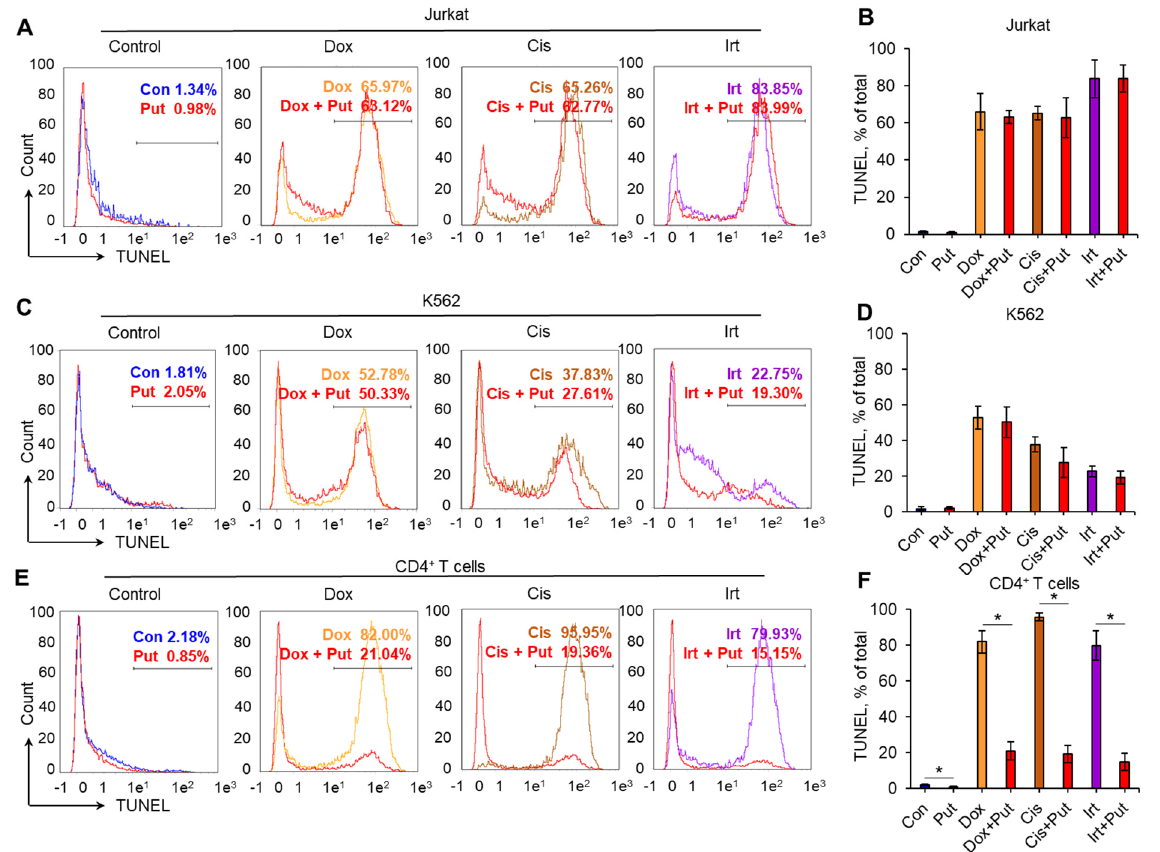
Figure 2. Decreased DNA damage in normal CD4 + T cells pretreated with PAs. Representative terminal deoxynucleotidyl transferase-mediated d-UTP nick end labeling (TUNEL) flow-cytometry diagrams for cancer cell lines ( A ) Jurkat, ( C ) K562, or ( E ) normal CD4 + T lymphocytes pretreated with each PA and incubated with genotoxic agents. The results of the TUNEL assay for flow cytometry for treated ( B ) Jurkat, ( D ) K562, or ( F ) CD4 + T cells. n = 4. * p ≤ 0.05. Con: control intact cells; Cis: cisplatin; Dox: doxorubicin; Irt: irinotecan; Spd: spermidine; Spm: spermine; Put: putrescine. n = 4. * p ≤ 0.05.